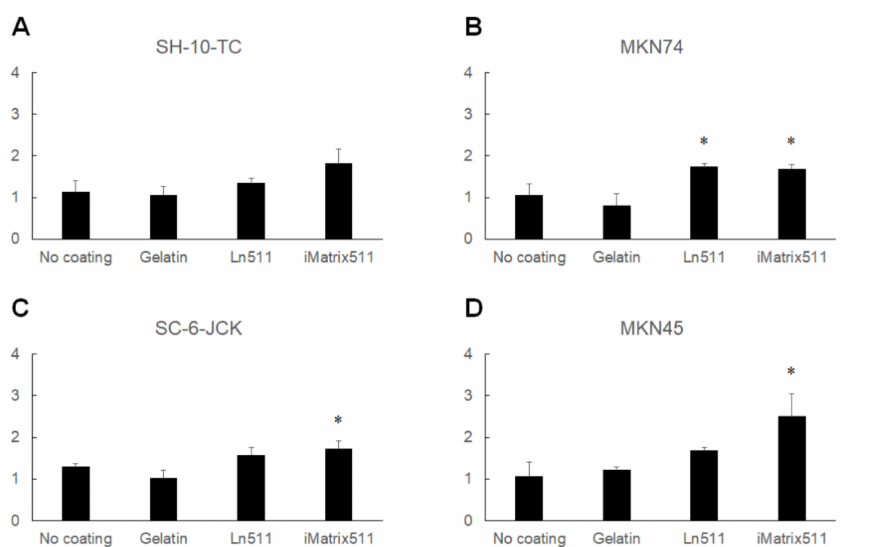
Figure 2. Results of the MTT/MTS assay. The proliferation of SH-10-TC gastric cancer cells cultured for 48 h is significantly higher on the Ln511-E8 fragment than on the control (no coating) ( A ). MKN74 cells display greater proliferation on the Ln511-E8 fragment than on the control (no coating) ( B ). Although markedly larger proliferative responses of SC-6-JCK ( C ) and MKN 45 cells ( D ) were found on the full-length Ln511 and Ln511-E8 fragments than on the control, the number of cells was largest when cultured for 48 h on the Ln511-E8 fragment. These results indicate that Ln511-E8 fragment promotes gastric cancer cell proliferation. * p < 0.05, ** p < 0.01, as indicated (vs. no coating). Data are presented as the mean ± standard deviation of three independent experiments.